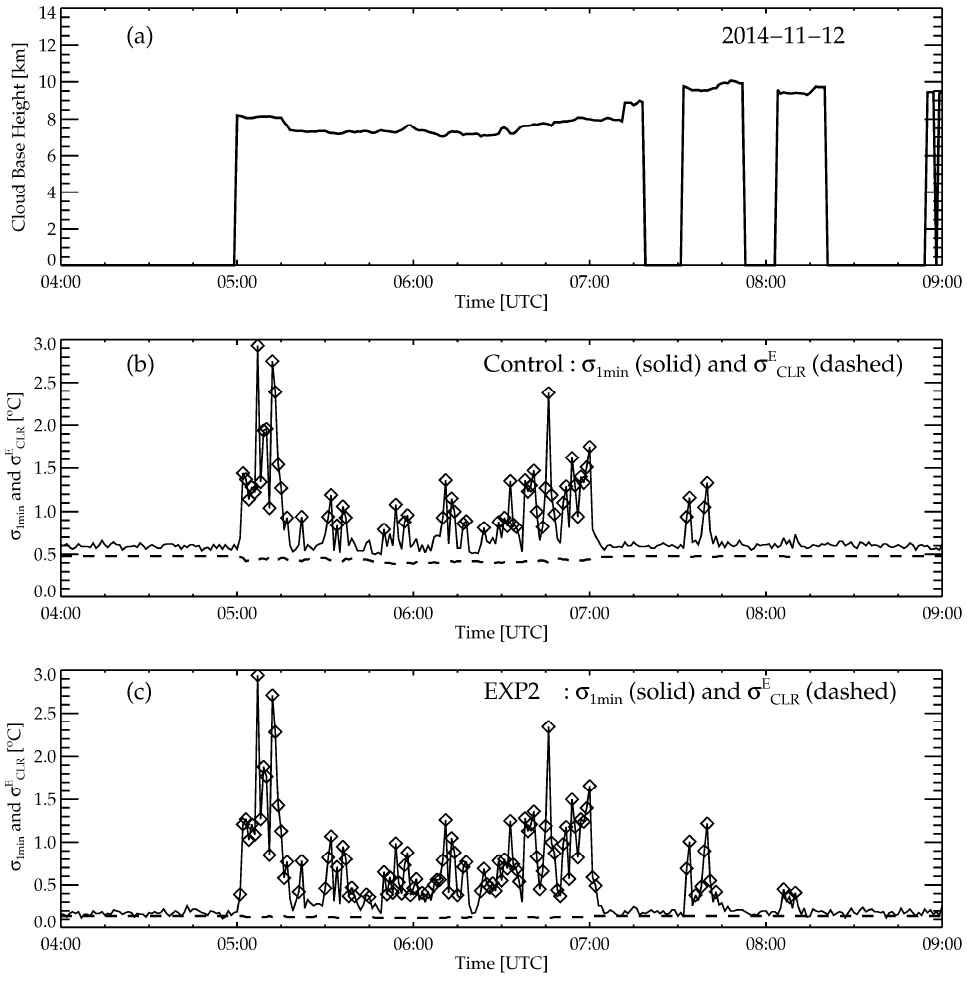
Figure 6. Time series of the ( a ) MPL CBH (solid line), the temporal variability, σ 1min (solid line), and the expected clear sky temporal variability, σ ECLR (dashed line) for ( b ) the Control and ( c ) EXP2 for 5 h on 12 November 2014. Here, the diamonds indicate successful cloud detection by the temporal test: 61 data points for the Control versus 104 data points for EXP2.